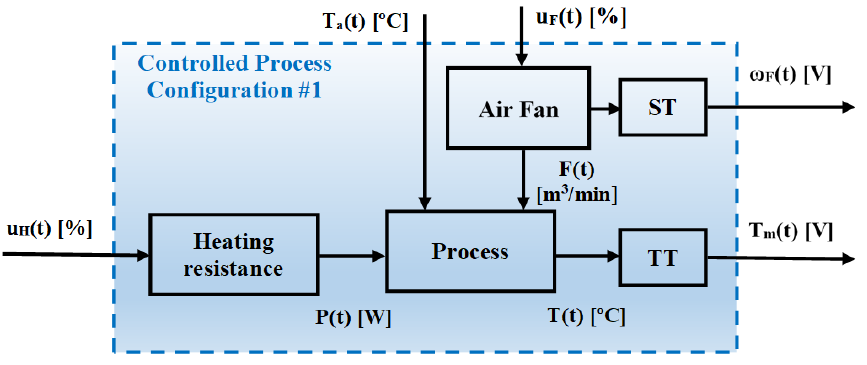
Figure 8. Block diagram for the controlled process configuration #1.